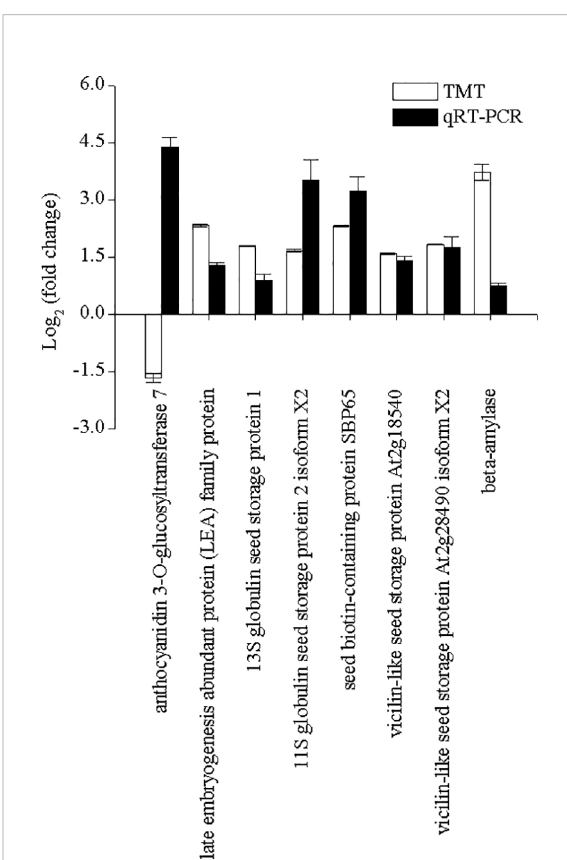
FIGURE 7 The changes in eight selected differentially accumulated proteins were determined by performing the tandem mass tag and qRT- PCR analyses in quinoa from different developmental stages. The selected DAPs included beta-amylase (AUR62014945-RA), 13S globulin seed storage protein 1 (AUR62002139-RA), 11S globulin seed storage protein 2 isoform X2 (AUR62024716-RA), vicilin-like seed storage protein At2g18540 (AUR62003182-RA), vicilin-like seed storage protein At2g28490 isoform X2 (AUR62006523-RA), seed biotin-containing protein SBP65 (AUR62037387-RA), late embryogenesis abundant protein family protein (AUR62022650- RA), and anthocyanidin 3-O-glucosyltransferase 7 (AUR62028163- RA). Tub-6 was used as the housekeeping gene. The data are presented as the mean ± SE of three replicates ( p <